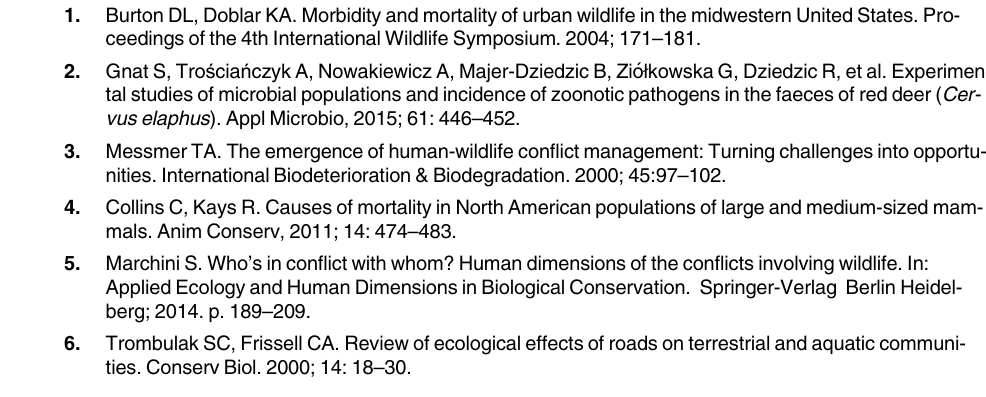
S1 Table. All broad and specific causes for admission. A complete list of the broad specific causes for admission and the corresponding specific causes for admission that were used to categorize the admissions records from a wildlife rehabilitation facility in the Midwest,